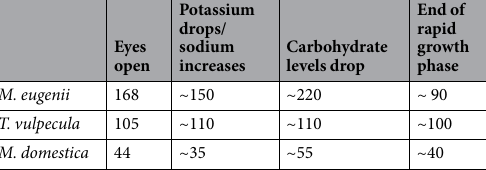
Table 4. Timing of early developmental milestones (in postnatal days). Eye opening data from Workman 25 and references therein; milk composition data for T. vulpecula from Cowan 64 , for M. domestica from Green et al . 65 and for M. eugenii from Sharp et al . 59 .